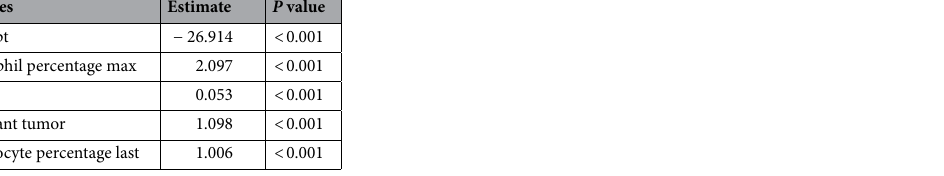
Table 4. Final model coefficients. Last: The last test results before the diagnosis of pulmonary embolism. Max: The maximum test results before the diagnosis of pulmonary embolism.